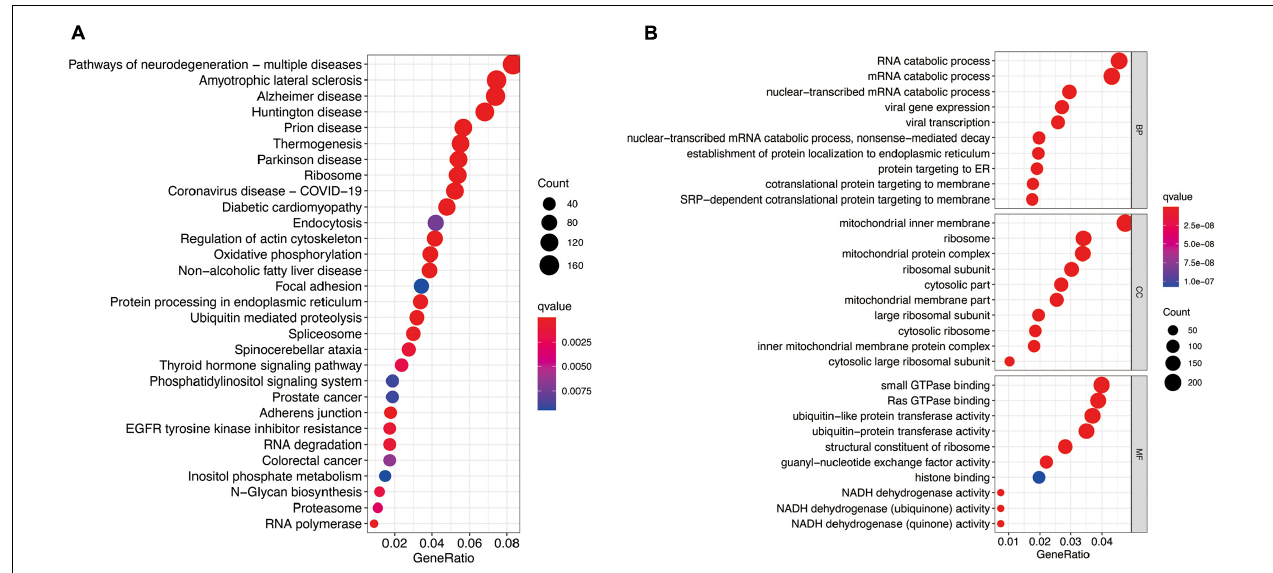
FIGURE 7 | Functional analysis based on the molecular subtype-related DEGs in TCGA cohort. (A) Kyoto Encyclopedia of Genes and Genomes pathways. (B) The significant categories as determined by Gene ontology analysis. The figure represents biological process (BP), cellular component (CC), and molecular function (MF) genes from top to bottom. The bigger bubble means the more genes enriched, and the increasing depth of red means the differences were more obvious. qvalue, the adjusted P -value.